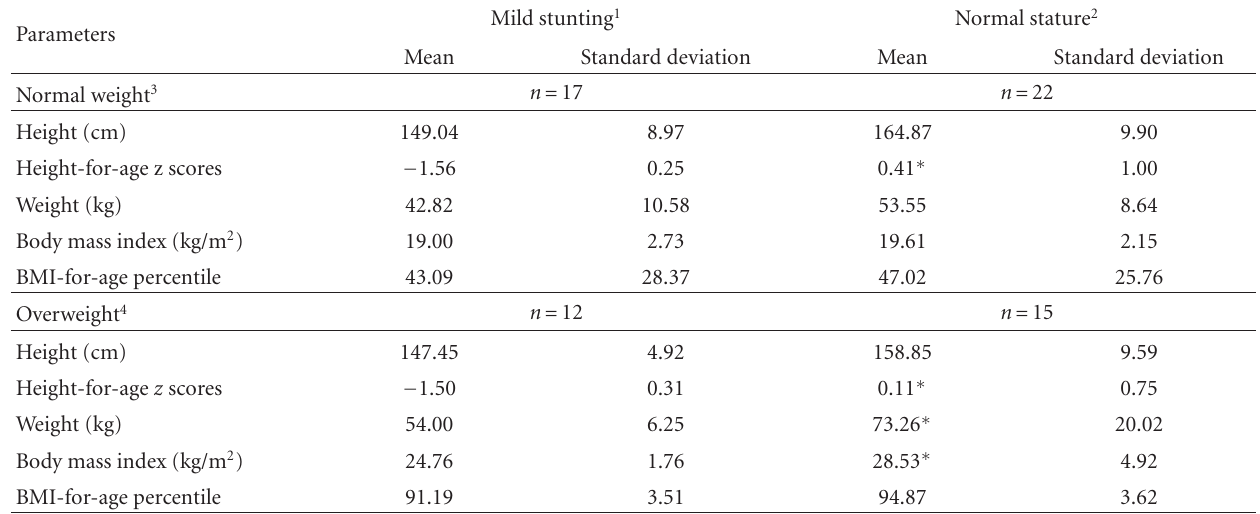
Table 2: Anthropometric characteristics of the study population.